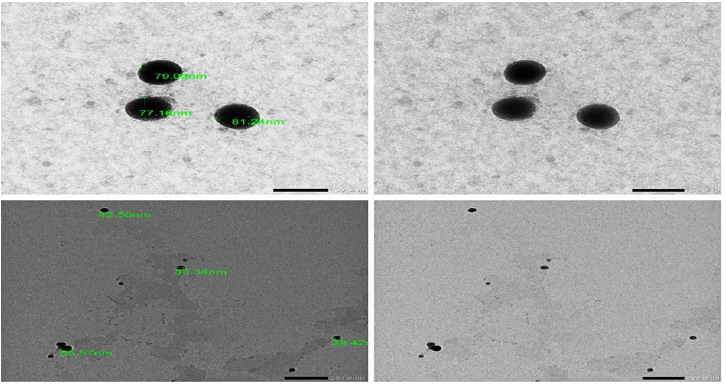
Fig 2. Representative transmission electron microscopy analysis of prepared Se-NPs showing their size and